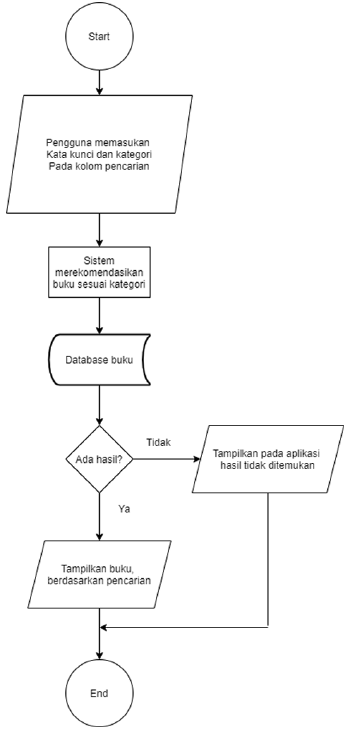
Fig. 1. Flowchart of artificial intelligent in the